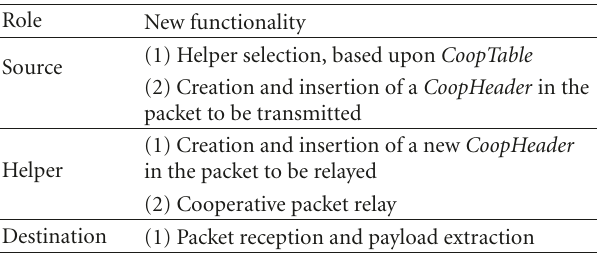
Table 2: Summary of implemented functionality. Role